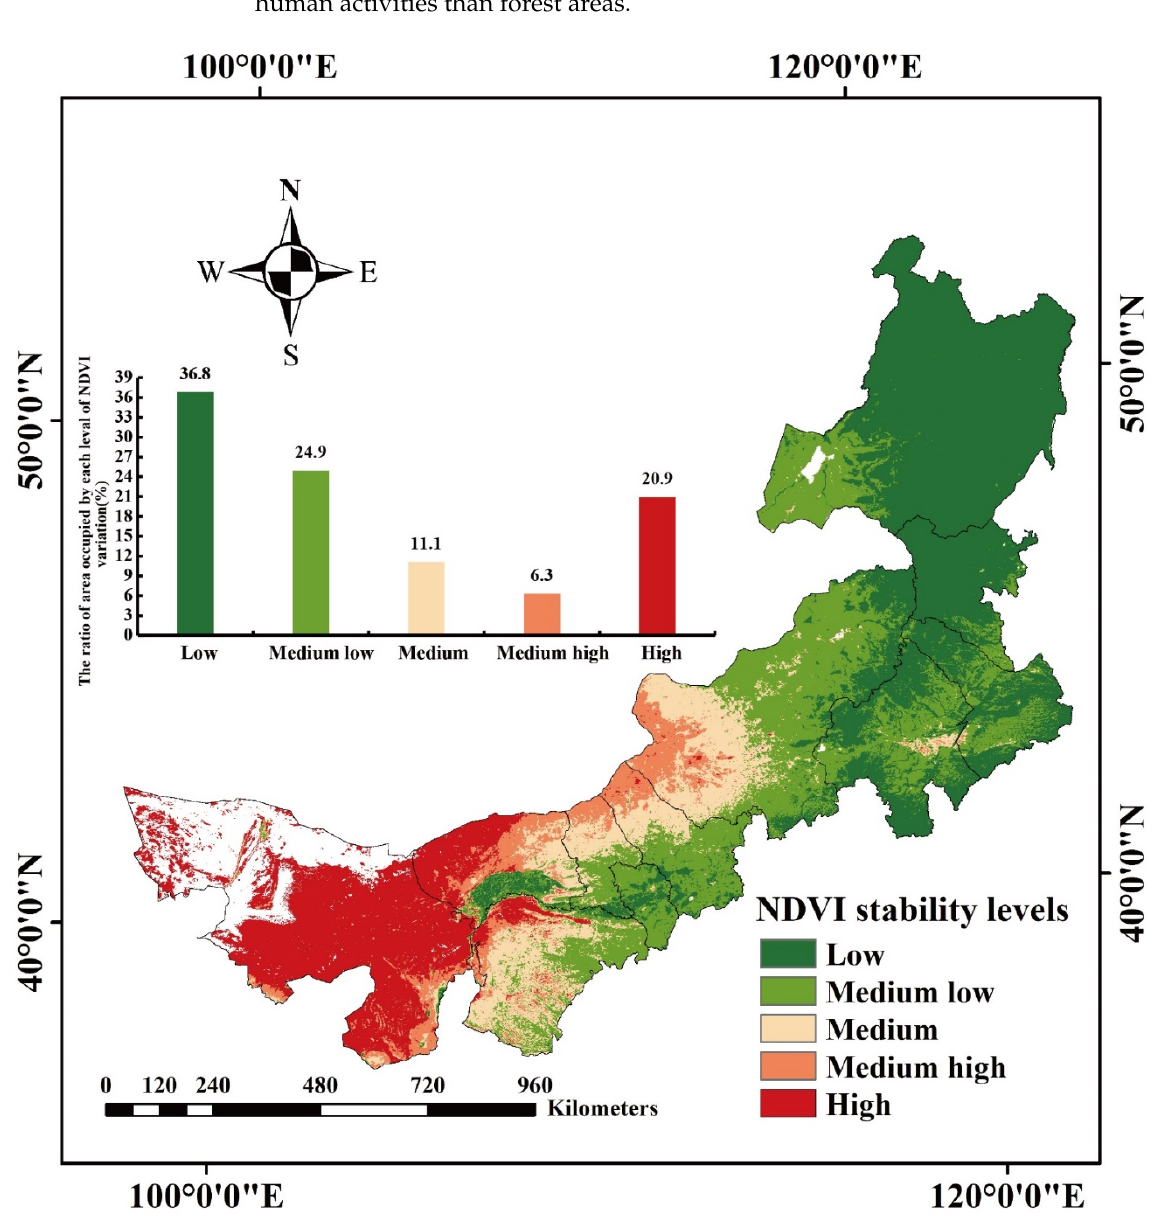
Figure 5. Spatial distribution of NDVI stability levels in Inner Mongolia from 2000 to 2019.